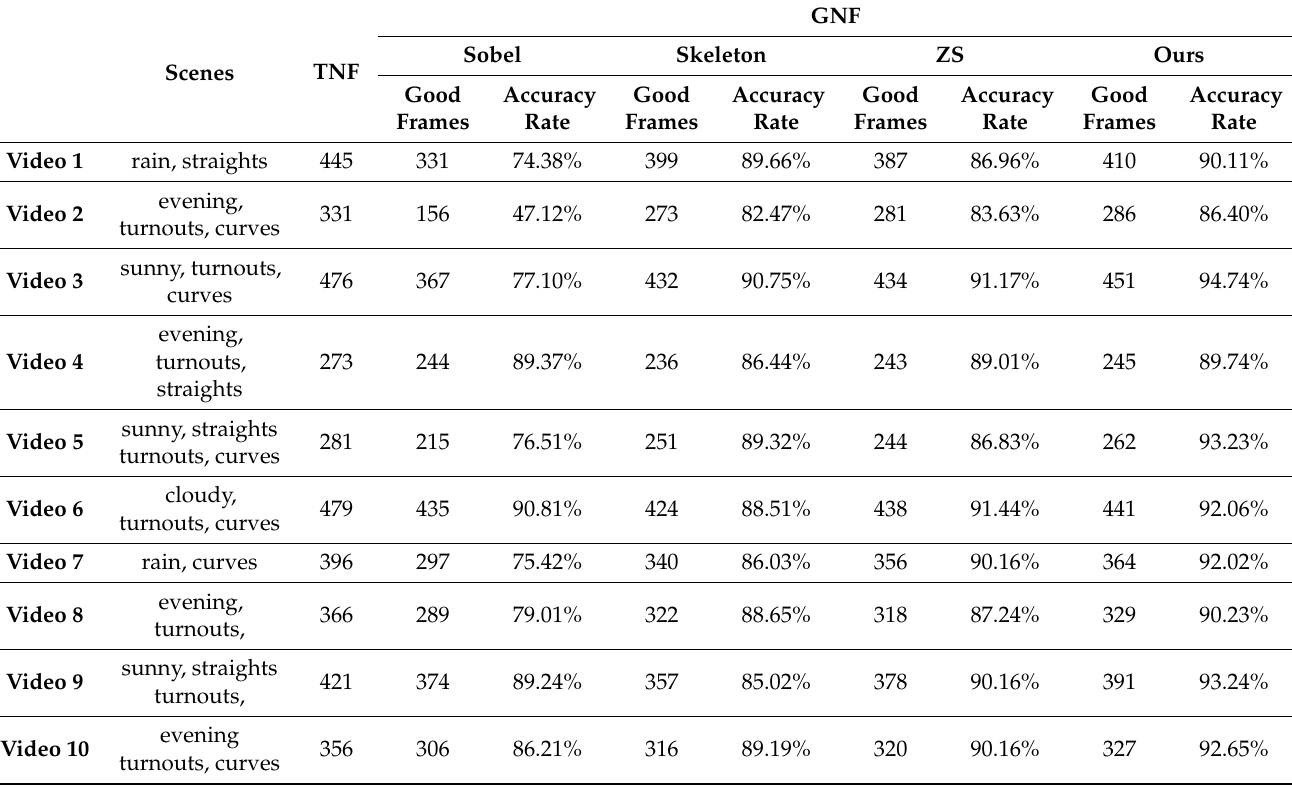
Table 2. The results of the comparative experiment under freight railway scenario.